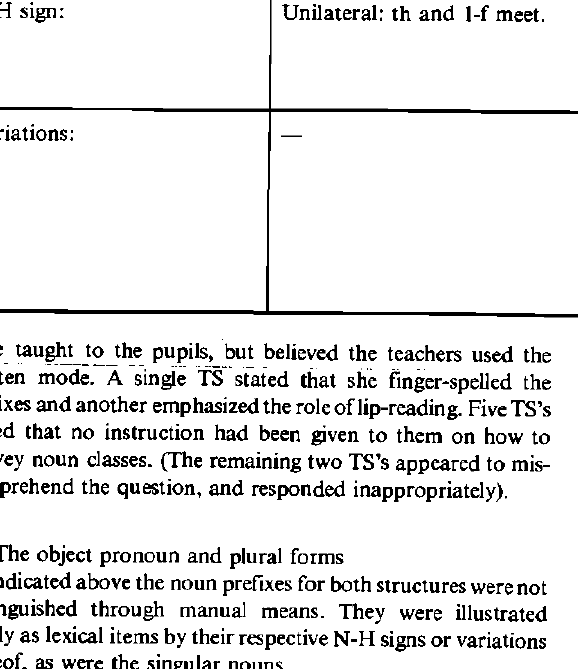
Table 4 Description of the Nieder-Heitmann object pronoun sign across the cheremic configurations, and variations thereof SIGN DEZ TAB SIG Side of body (same side as ! N-H sign: Unilateral; 1-f points diagonally Stationary downwards. hand involved) Variations: Dez 1: Bilateral Tab 1: f points to front of body. Sig 1: hand moves across body, Dez 2: f points straight or Tab 2: f points above head. diagonally upwards. Table 5 Description of the Nieder-Heitmann plural sign across the cheremic configurations, and variations thereof SIGN DEZ TAB SIG N-H sign: Unilateral: th and 1-f meet. Side of chest below shoulder of Move hand across chest from" opposite side. shoulder on same side to lower position below shoulder of opposite side.